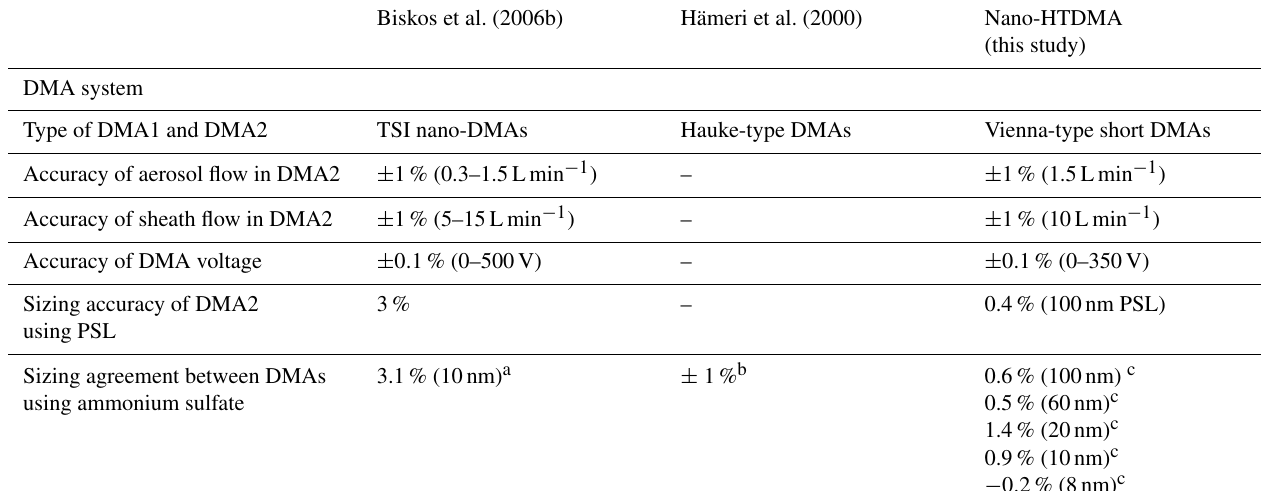
Table 1. Accuracy, precision, and sources of uncertainty associated with HTDMA measurements. Note: GE – general eastern. Biskos et al. (2006b)